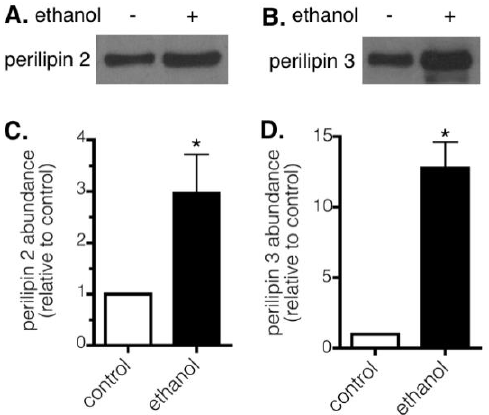
Figure 4. Chronic ethanol exposure alters the protein composition of hepatic LDs. Levels of perilipin 2 ( A , C ) and perilipin 3 ( B , D ) in equivalent amounts (per gram) of liver tissue were determined by SDS-PAGE and Western blotting. ( A , B ) Representative Western blots from control ( − ) or ethanol (+) treated rats are shown. ( C , D ) Summary data are average values relative to the control ± SEM from five experiments. Asterisks indicate values for ethanol-treated rats are statistically different than 1.0 (*, p < 0.04, Wilcoxon signed-rank test).